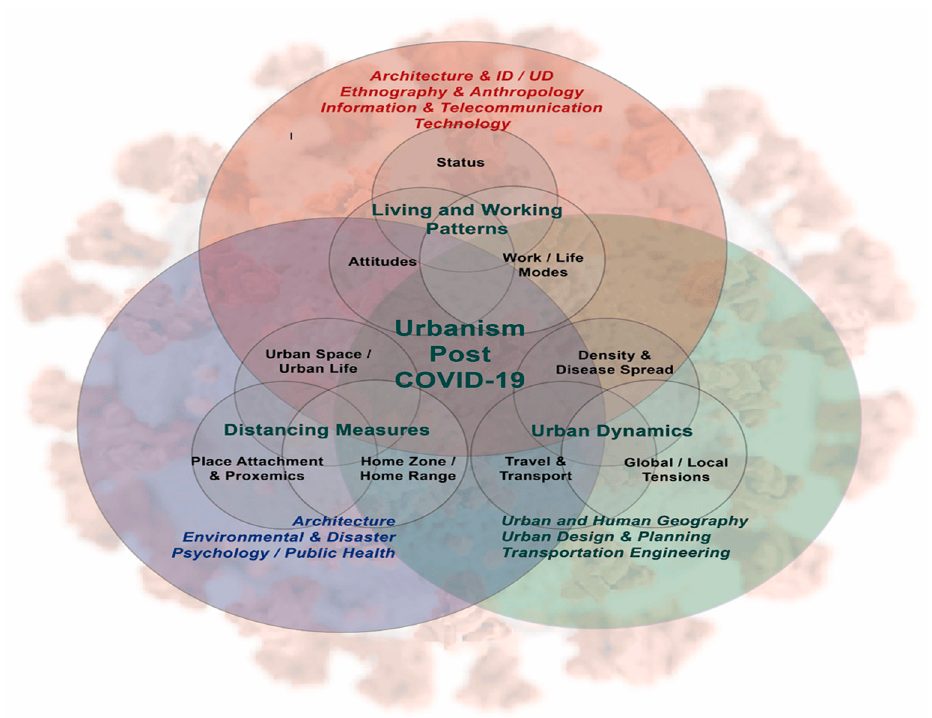
Figure 14. A multidisciplinary framework for mitigating the urban and social impacts of the measures of COVID-19 (Adapted from [131] ).